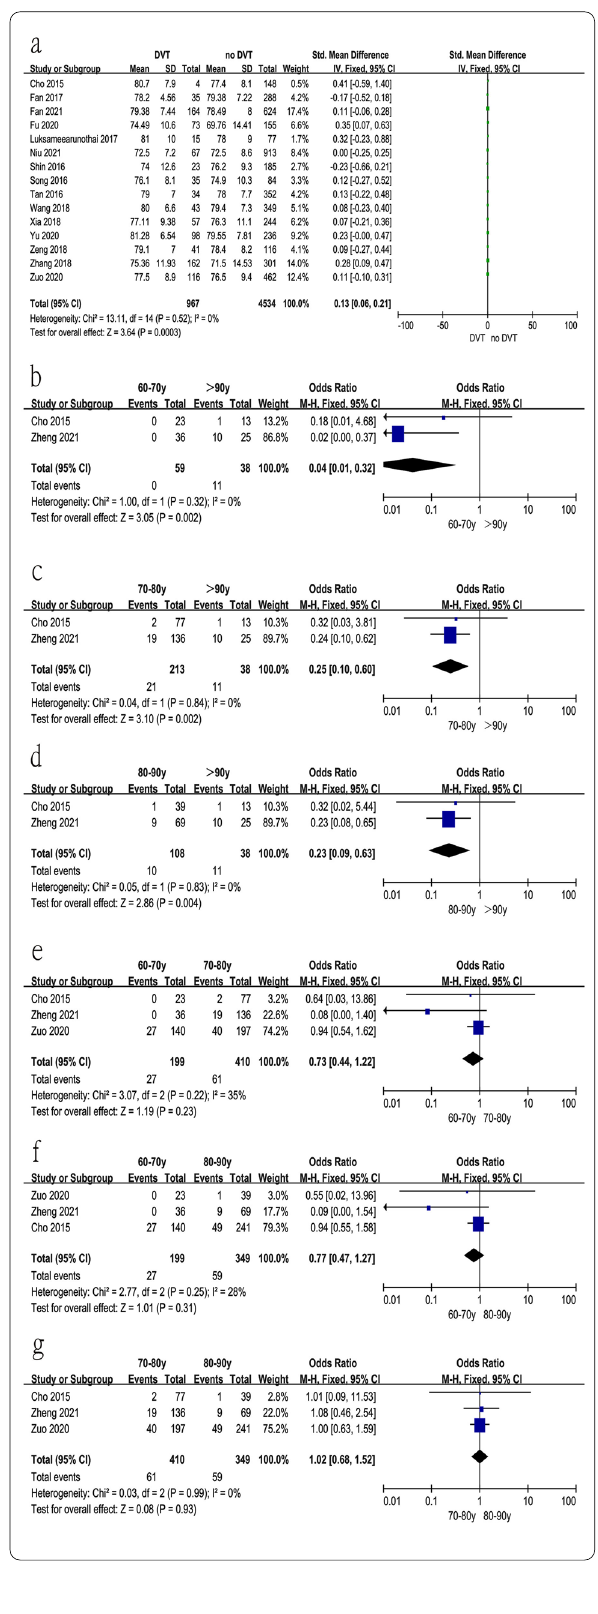
Fig. 2 Forest plot showing age in 2 groups. CI confidence interval, df degrees of freedom, M-H Mantel–Haenszel. a Relationship between age at surgical time and preoperative DVT; b 60–70 years vs > 90 years; c 70–80 years vs > 90 years; d 80–90 years vs > 90